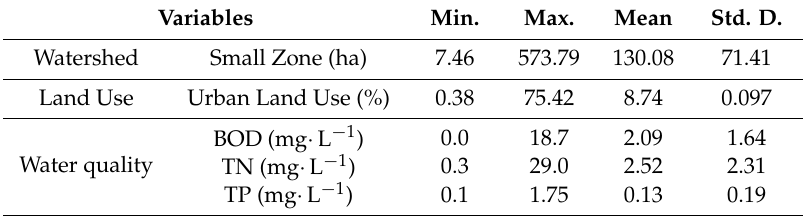
Table 1. Descriptive statistics for water quality indices and the proportions of urban land use. A large variation in the variables was observed in the study